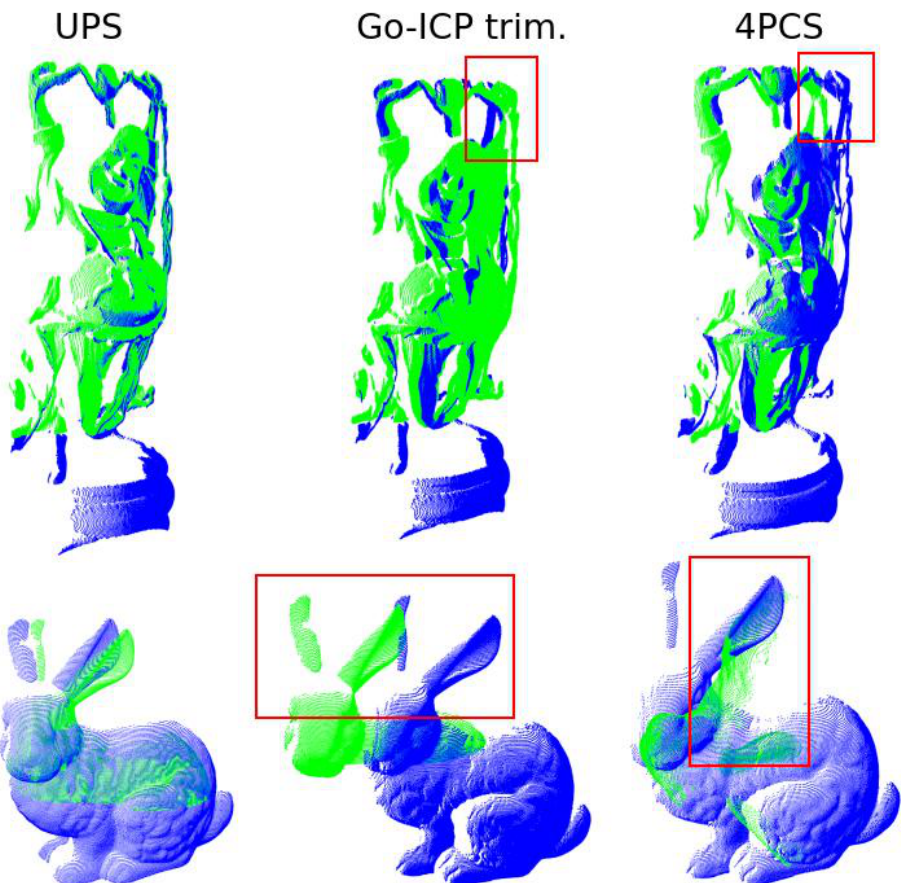
Figure 12. Partial-overlap UPS registration of Buddha and Bunny models and comparison to Go-ICP trimming and 4PCS. In the red boxes, regions with large correction errors are